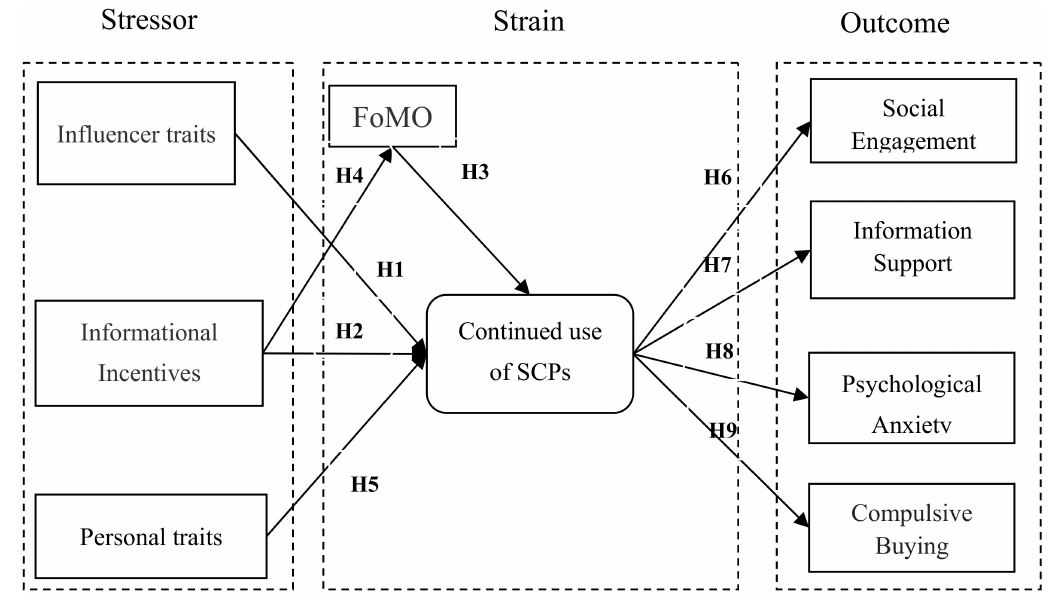
Figure 1. Research